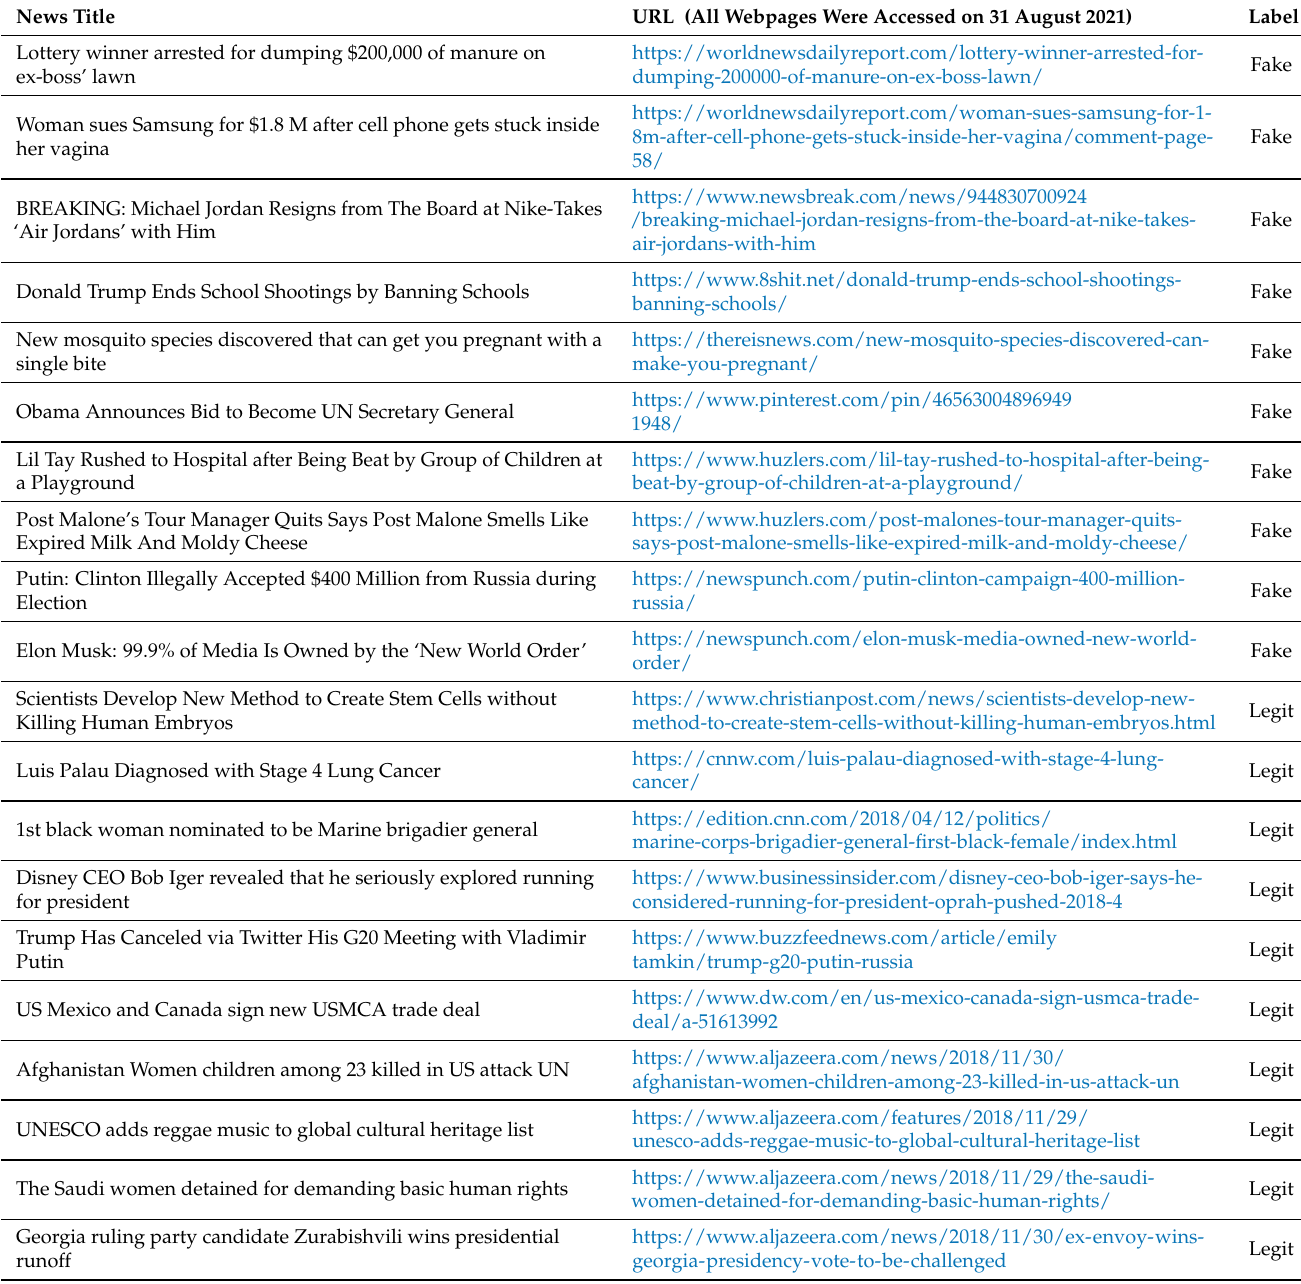
Table 2. The manually selected 20 news-item dataset (10 fake and 10 true news items) for the manual experiment. Fake news items were selected from the top 50 fake news items of 2018 according to BuzzFeed. Legit news items were selected from the NELA-GT-2018